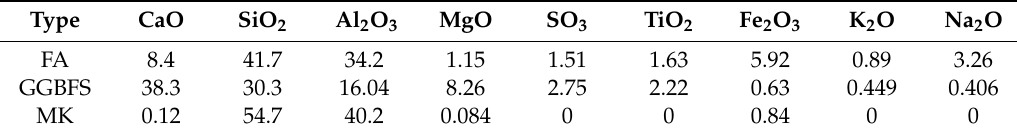
Table 1. Mineral compositions of admixtures (%).